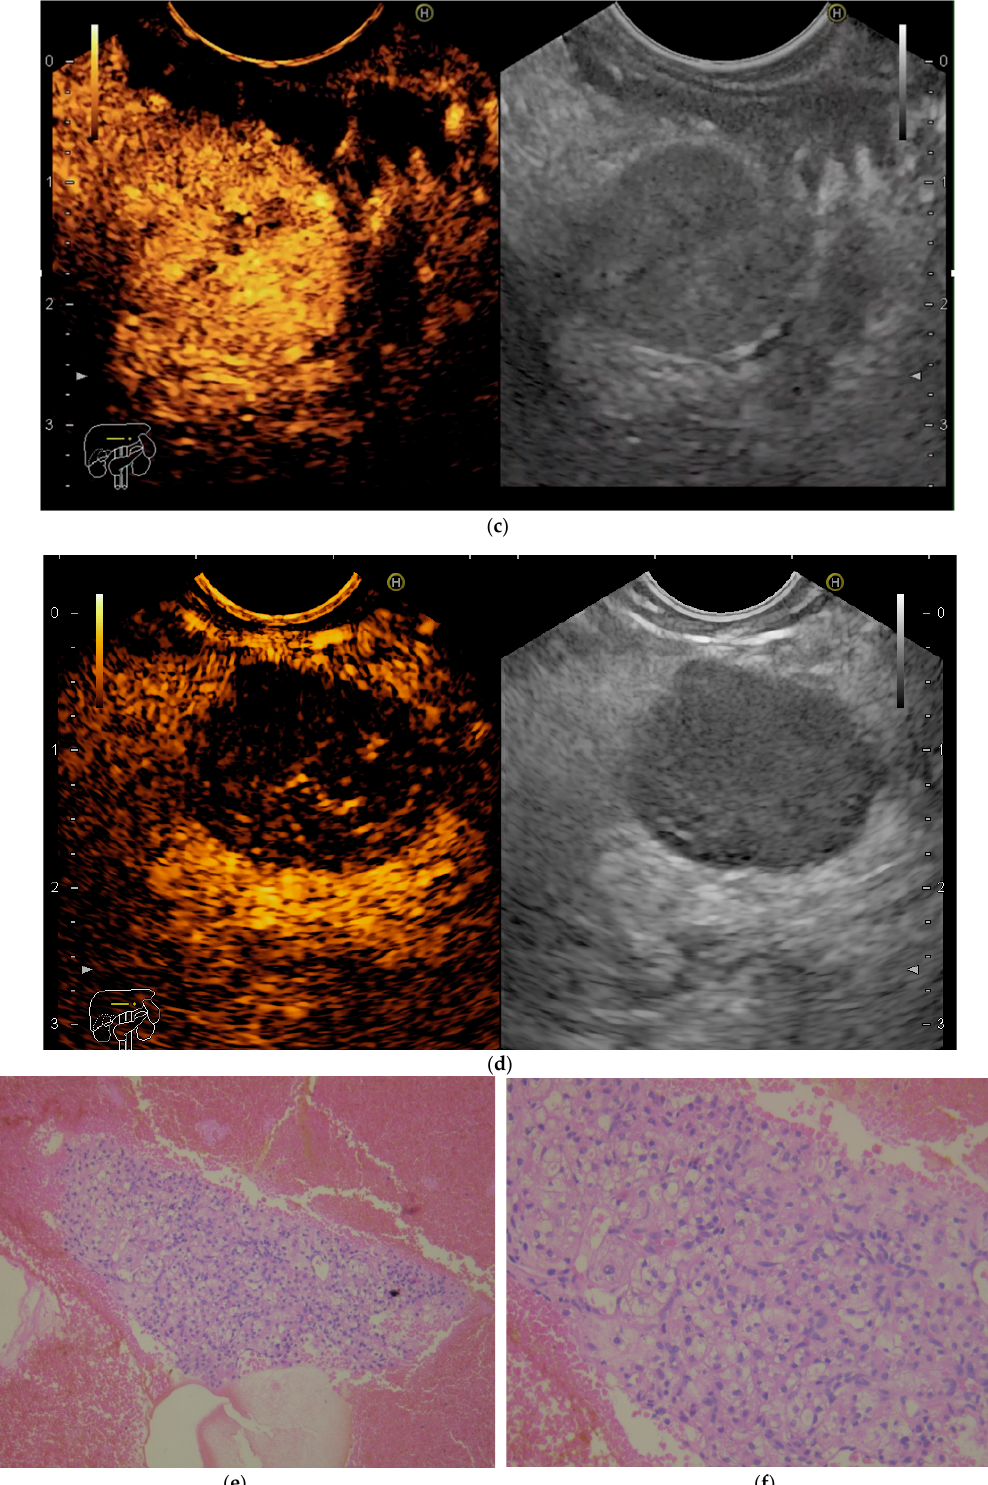
Figure 1. ( a ) Endoscopic ultrasound using a linear probe: hypoechoic mass in the isthmus of the pancreas. ( b ) Real-time elastography showing a hard homogeneous pattern in the lesion. ( c ) Contrast-enhanced EUS showing a hyperenhancing pattern of the lesion in the arterial phase. ( d ) Contrast-enhanced EUS image showing washout of the lesion in the late phase. ( e , f )—Hematoxylin-eosin stain, 100× and 200× magnitude, showing RCC tumor proliferation.